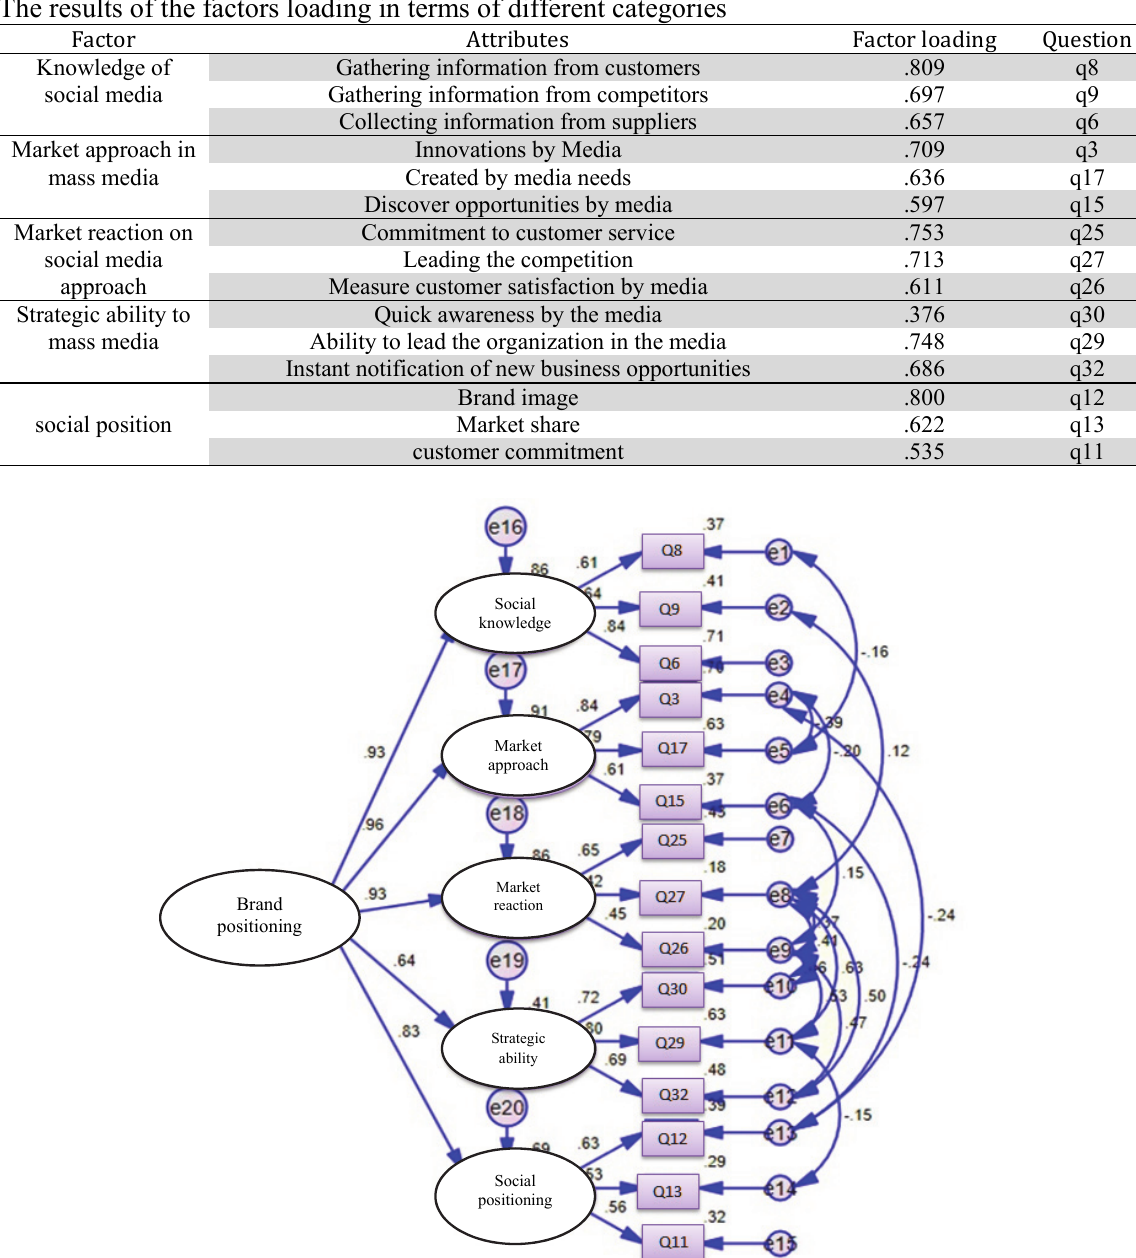
Fig. 2. The results of factor